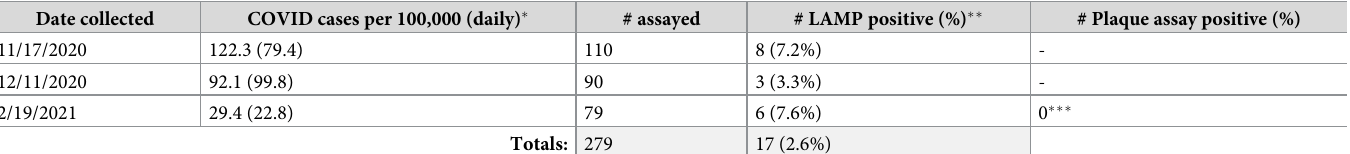
Table 2. LAMP assays for detection of SARS-CoV-2 RNA on money cards on Brigham Young University (BYU)